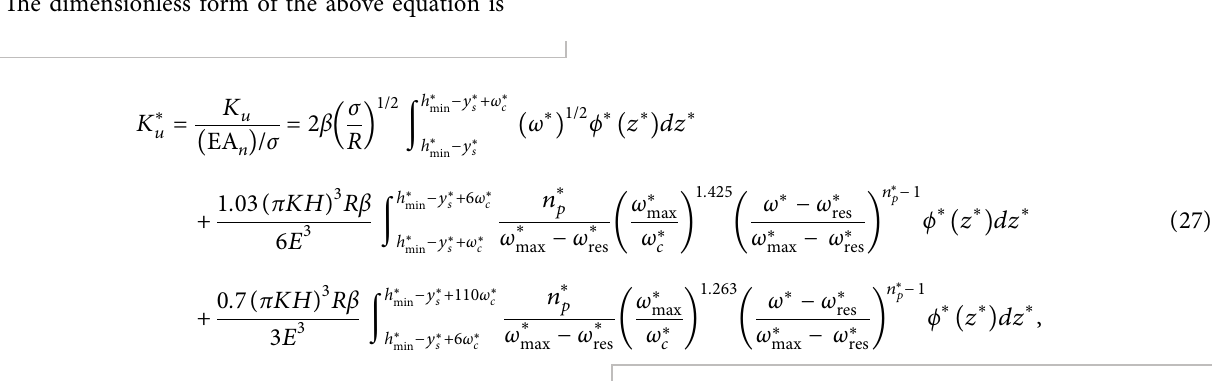
R � 6 . 89 × 10 − 4 mm, and the dimensionless surface rough- ness parameters β and σ / R [17] (shown in Table 1).